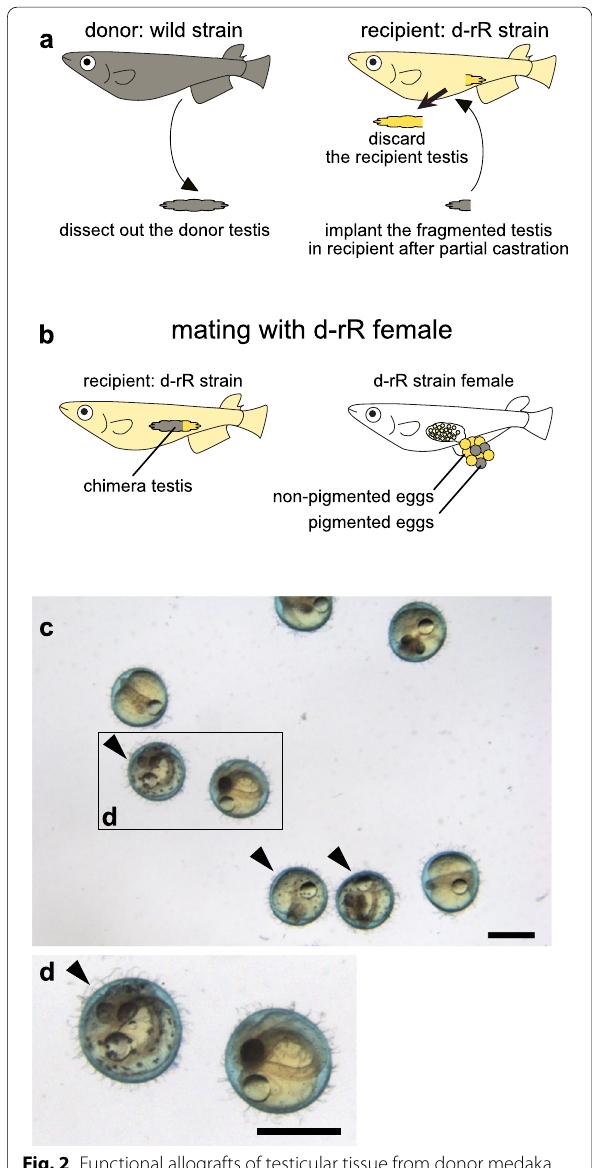
Fig. 2 Functional allografts of testicular tissue from donor medaka with a different genetic background to the recipients. a An outline of the surgical procedure used here. b An outline of the mating scheme used here. In medaka, females lay eggs after spawning and keep the eggs attached to their belly for awhile. Pigmented eggs are produced following fertilization by spermatozoa of wild‑derived strain germ cells. Non‑pigmented eggs result from fertilization with d‑rR strain sperm. c Representative image of eggs fertilized by a recipient that had been transplanted with testicular tissue from a wild‑derived medaka strain; arrowhead, pigmented egg resulting from fertilization with a wild‑derived spermatozoon; scale bar, 1 mm. The boxed area is magnified in panel d